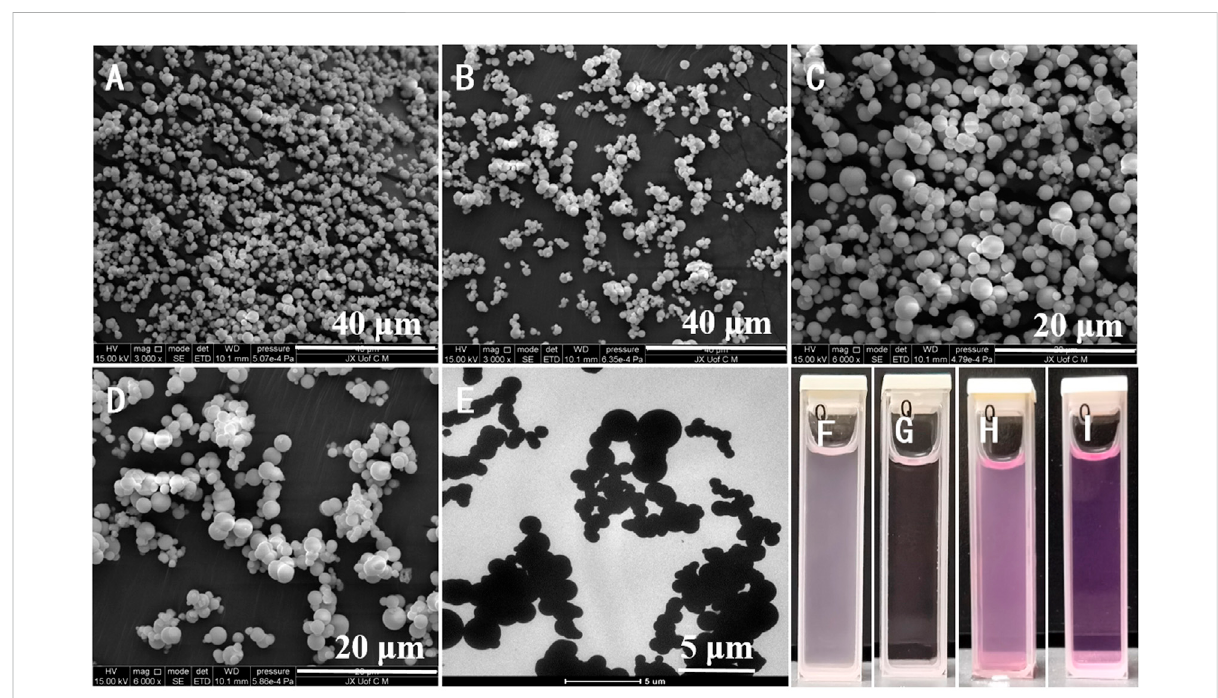
FIGURE 1 Surface morphology evaluation of the developed Eu-CP-Ara by SEM at different magni fi cations (A – D) . TEM images of Eu-CP-Ara micro/ nanosphere assembly. The scale micro/nanosphere of the inset is 100 nm~2.5 μ m (E) . Eu-CP-Ara micro/nanosphere with a concentration